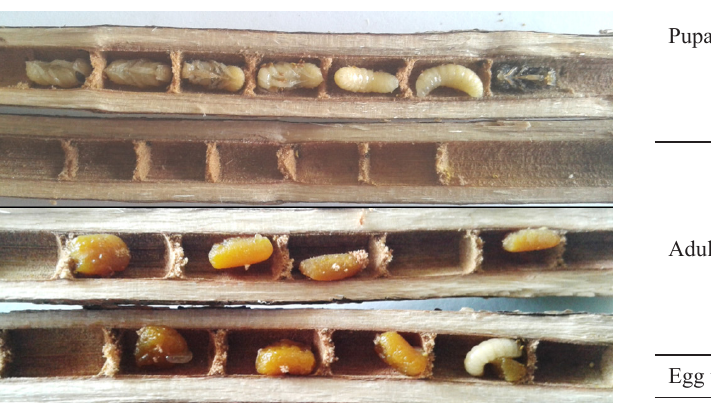
Fig 2. Full brood nest and pollen provision made by Ceratina binghami in pithy stems of Caesalpinia pulcherrima .